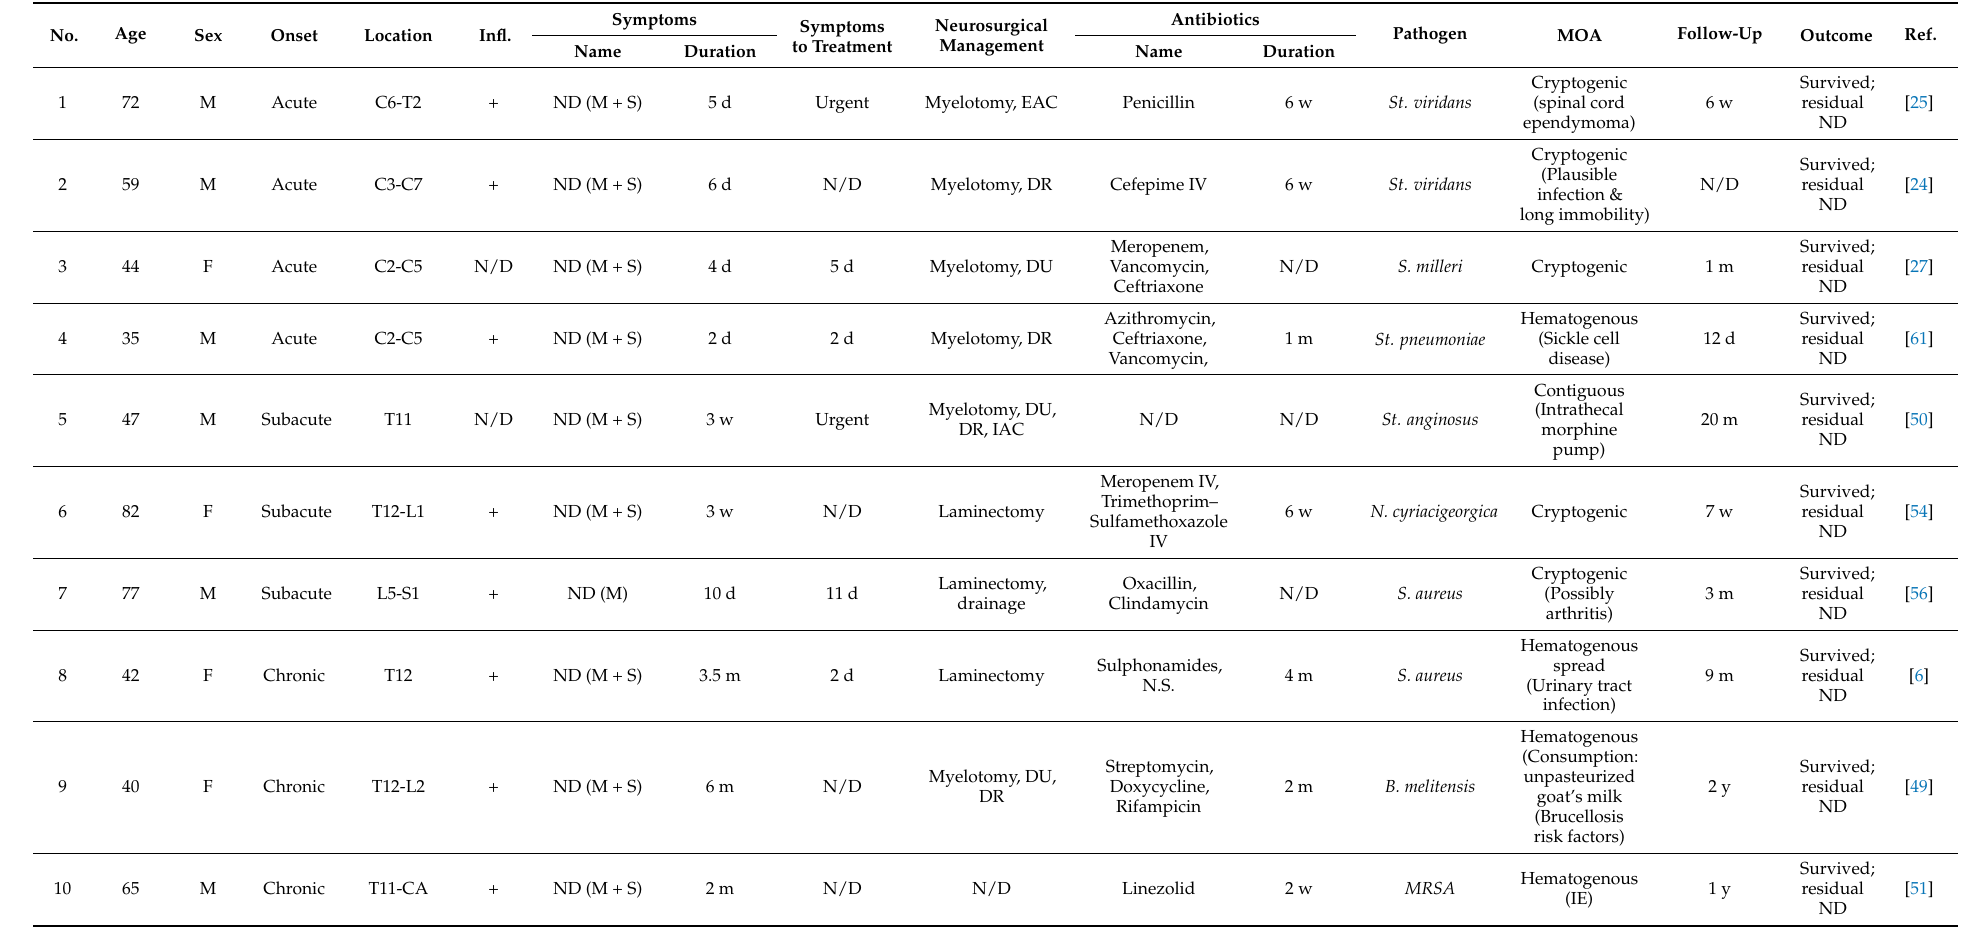
Table 3. Residual group—summary of the clinical data, patient demographics, clinical manifestations, duration, microbiology, interventions and therapies,